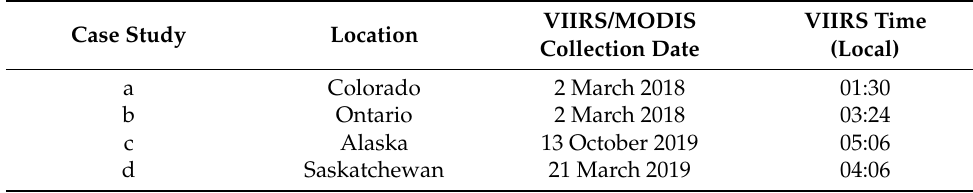
Table 1. Date and time of data collection by case study area. Case Study